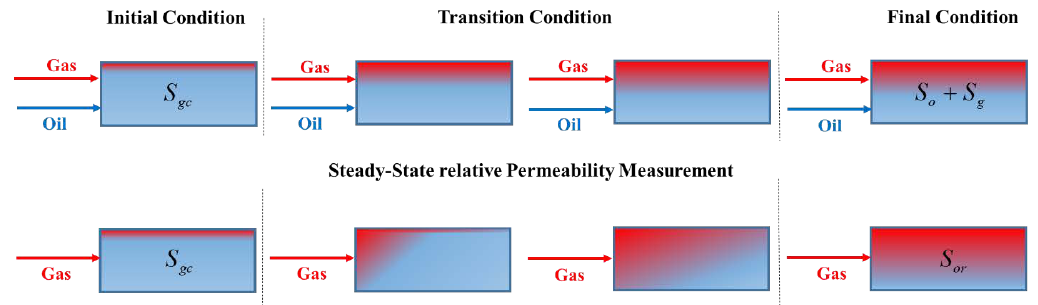
Figure2. Conceptualdepictionofexperimentalproceduresingas / oilsteady-andunsteady-state-relative permeability measuring Figure 2. Conceptual depiction of experimental procedures in gas/oil steady- and unsteady-state- relative permeability measuring techniques.